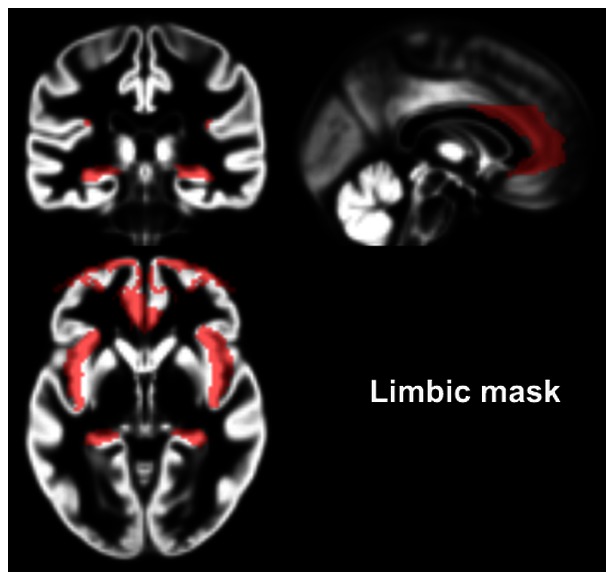
Illustration of the limbic mask, constructed from the WFU-pick atlas (please see methods), superimposed on the mean grey matter images from the entire study population.